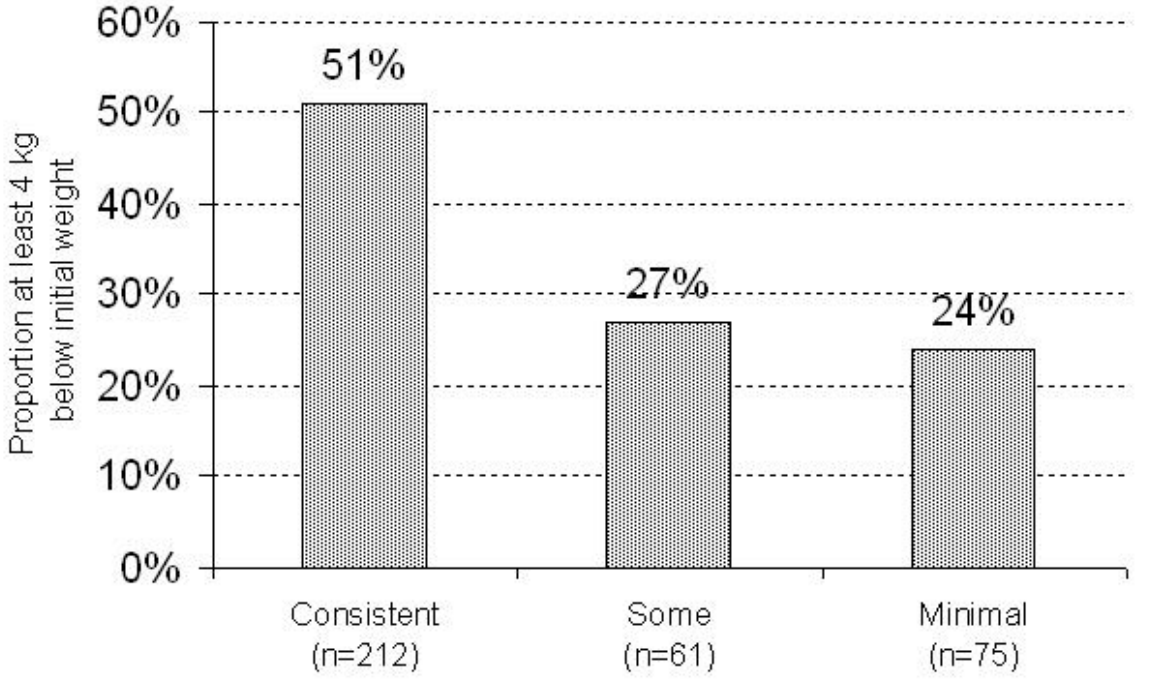
Figure 4. Proportion of participants at least 4 kg below initial weight for each website use category (two-tail P value testing for any differences based on logistic regression analysis adjusted for race, sex, education, income, and age, P =